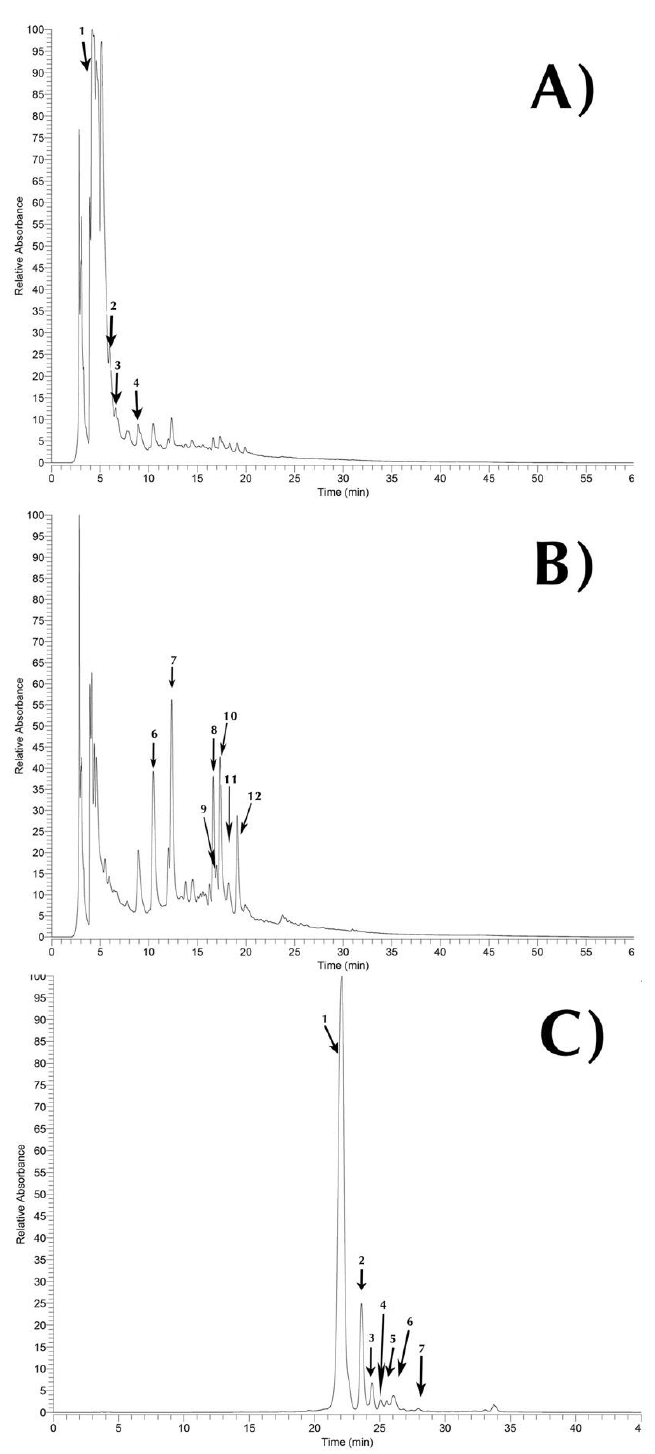
Figure 1. HPLC chromatogram of Opuntia engelmannii cv. Valencia peels phenolic and betalainic profile recorded at 280 nm Ph1–Ph4 phenolic acids ( A ), 370 nm Fv1-Fv8 Flavonoids ( B ), and 535 nm Bc1-Bc7 Betalains ( C ). Peak numbers correspond to the compounds described in Table 1.